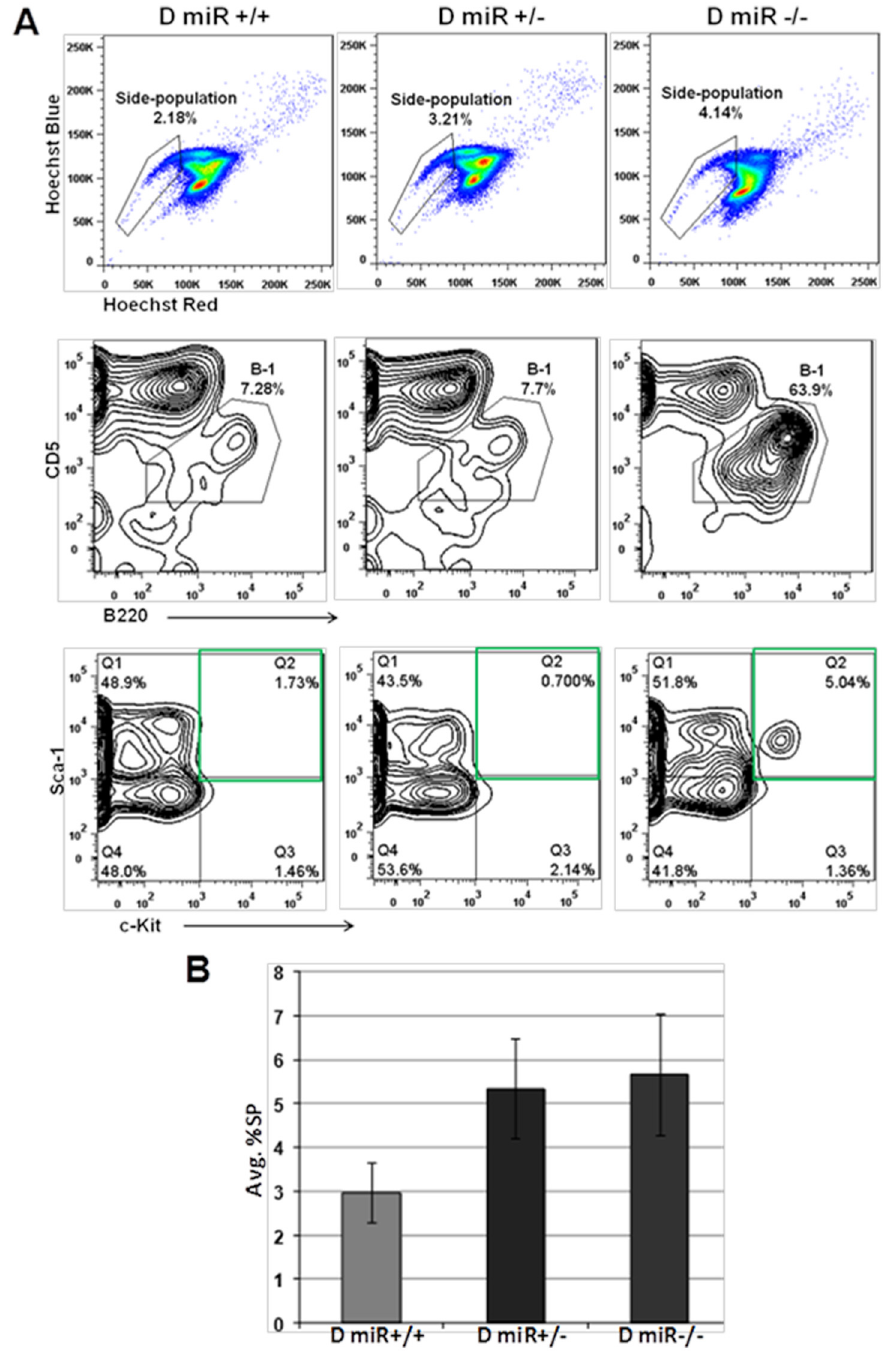
Fig 6. Side-population and SP B-1 in relation to miR-15a/16-1 status. Spleen cells obtained from DBA congenic mice which differed in the mir-15a/16-1 loci were analyzed for the presence of the sidepopulation (SP). A) Top — SP cells were visualized using Hoechst staining. The gates were drawn based on the blockage of dye efflux using verapamil in the corresponding mouse strain. Middle – The SP cells were further gated on CD5 and B220 to visualize the subpopulations in the SP fraction. Numbers indicate the percentage of CD5 + B220 dull/+ (B-1 cells) in D miR+/+ (left), D miR+/- (middle) and D miR-/- (right). Bottom — Contour plot of Sca- 1 and c-Kit stained cells in the SP gate. The Sca-1 + c-Kit + population is highlighted with a green box. B ) Average percentage of SP cells in D miR+/+ , D miR+/- and D miR-/- , n = 3 per